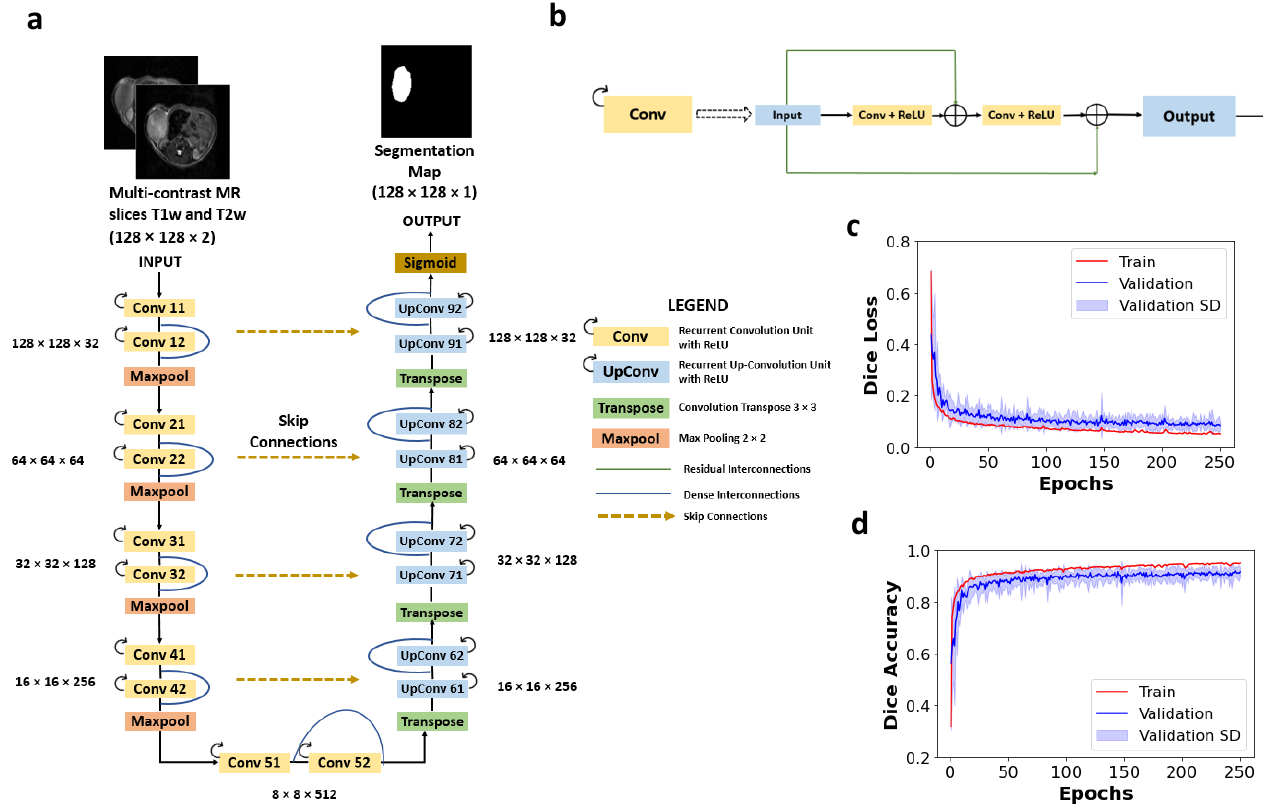
Figure 2. ( a ) Dense recurrent residual U-Net (D-R2UNet) architecture used for segmentation, ( b ) recurrent convolutional layer (RCL) unit of dense R2UNet, ( c ) model training and validation loss curve, ( d ) model training and validation accuracy curve for fivefold cross-validation. The validation standard deviation is shown in purple.